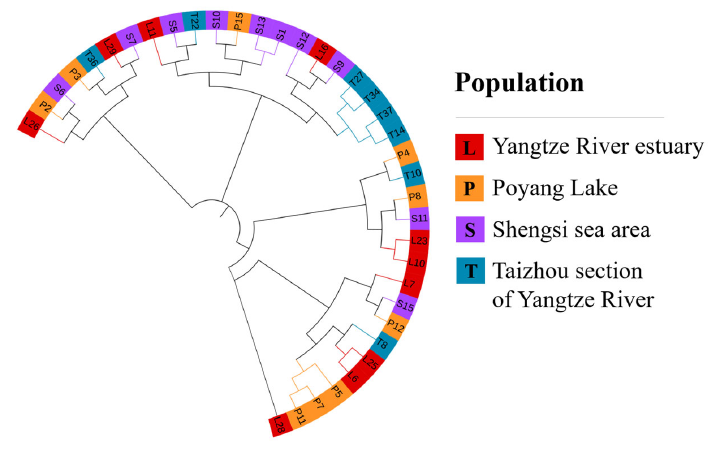
Figure 4. The phylogenetic tree.